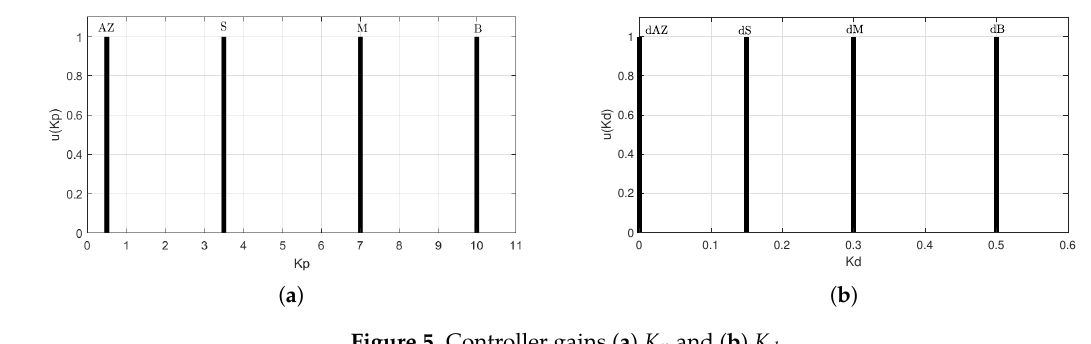
Figure 5. Controller gains ( a ) K p and ( b ) K d .